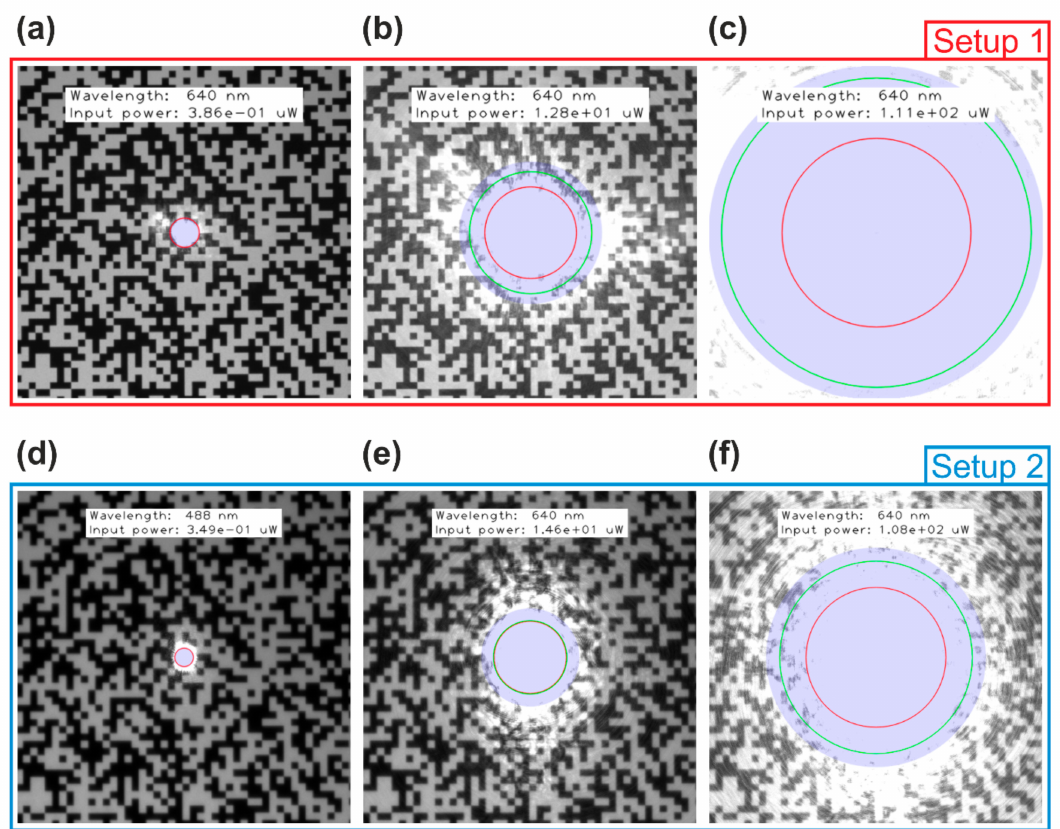
Figure 13. Laser dazzle spots recorded with two monochrome CMOS camera for a laser wavelength of 640 nm: ( a – c ): VRmagic VRmC-12 / BW Pro and ( d – f ) Allied Vision Mako G-158B. Additionally, calculated spot sizes are drawn into the camera images: Red circle: spot size for di ff raction only, green circle: spot size for scatter only, blue disk: spot size taking di ff raction and scatter into